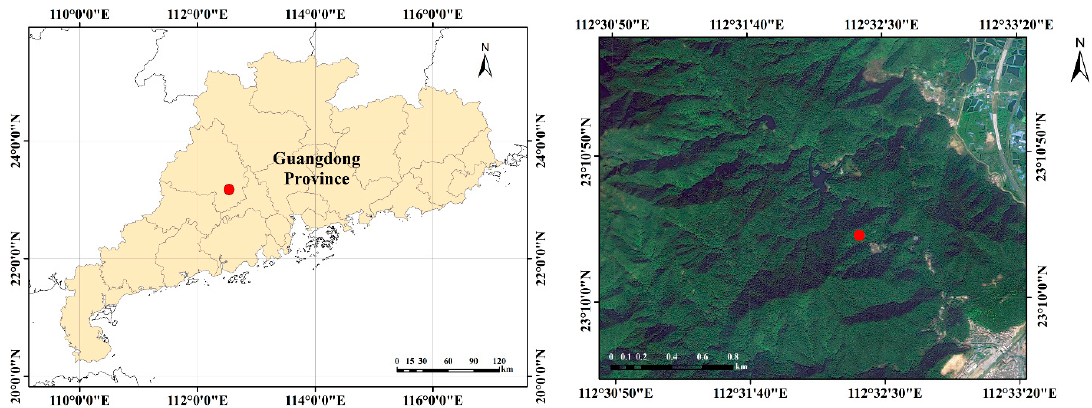
Figure 1. Location of the study site flux tower at the Dinghushan National Nature Reserve, Guangdong Province, China.